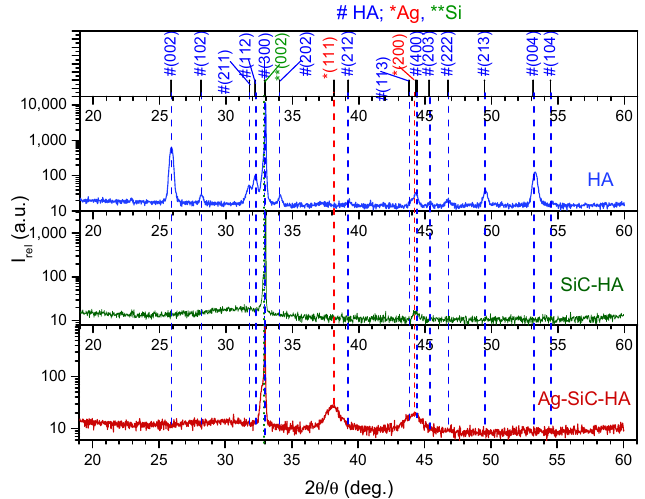
Figure 4. Diffraction patterns of the HA and doped HA coatings deposited on Si substrates. Considering the diffractograms of the HA coatings deposited on alloy and silicon, one can observe a higher number of maxima compared to the coatings deposited on TNZT alloy. The most intense maxima of the coatings deposited on Si are also those corresponding to (002) and (004) planes. Contributions from (102), (112), (202), (212), (400), (203), (222), (213) and (104) peaks are also visible on the HA diffractogram. Compared to the reference data, the calculated cell parameters of the HA coatings indicated a larger value of the “a” parameter (9.429(6) Å vs. 9.4180 Å) and lower value for the “c” parameter (6.867(3) Å